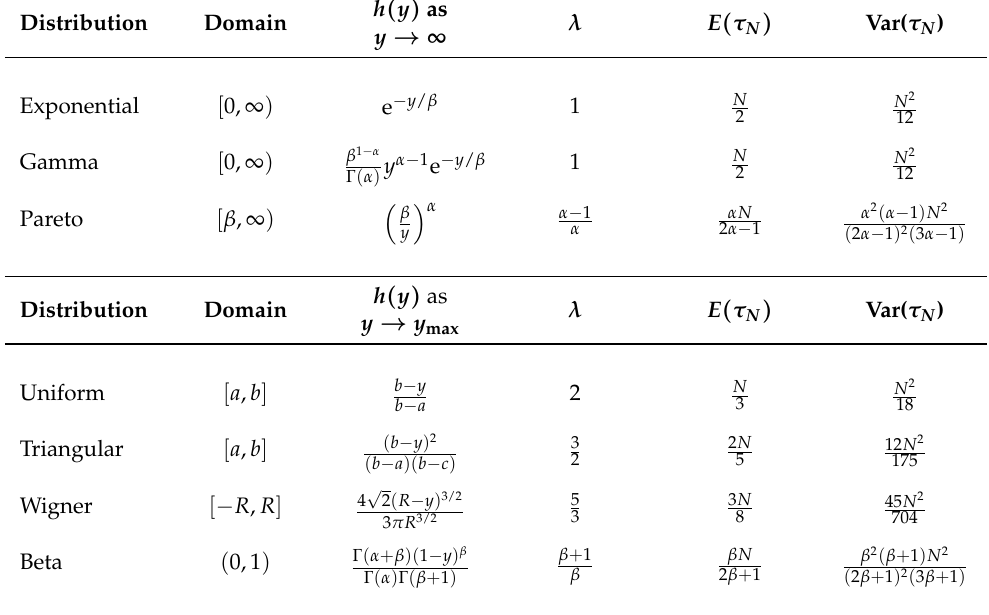
Table 2. This table contains the asymptotic behaviour of optimal stopping statistics for several common probability density functions, as well as the intermediate quantities used to compute these statistics. For each distribution, the table describes the pdf name and domain, the asymptotic behaviour of h ( y ) in the limit y → ∞ or y → y max for domains with infinite and finite upper support, respectively, and the value of λ associated with this asymptotic behaviour. The final two columns contain the expectation and variance of τ N in the limit N → ∞